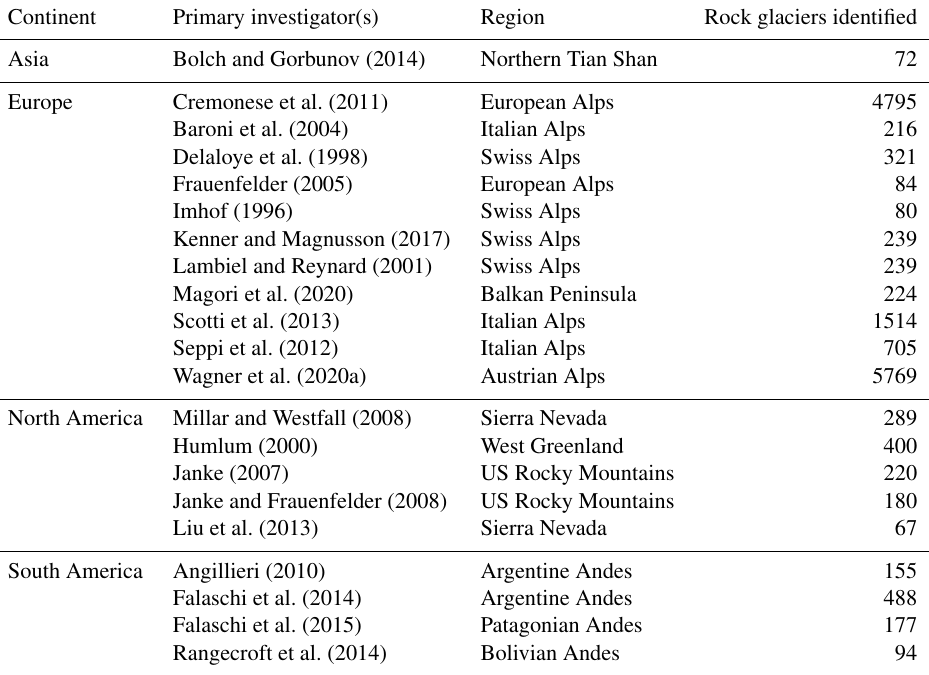
Table 1. Notable previous rock glacier inventories evaluated during comprehensive literature review. Only inventories that identified > 50 rock glaciers (i.e., at least regional scale) are included here, though sporadic smaller local inventories have been